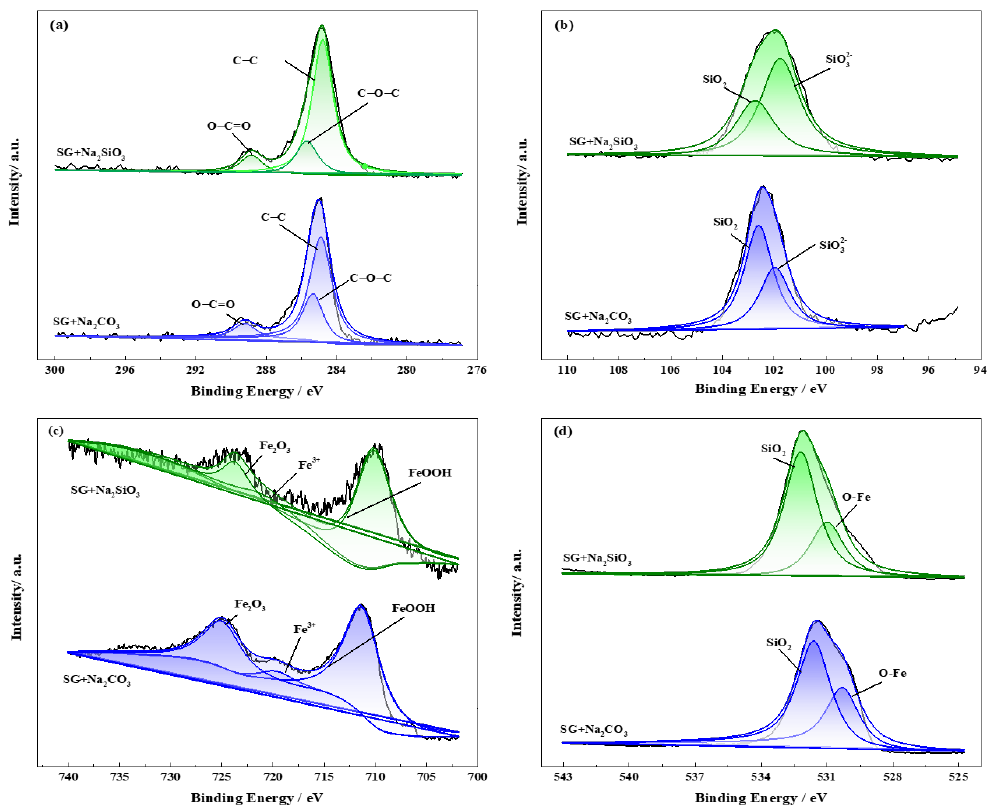
Figure 11. XPS spectra obtained on iron surfaces after 4 weeks immersion in the SG + 20 mM Na 2 CO 3 /Na 2 SiO 3 solution. ( a ) C 1s; ( b ) Si 2p; ( c ) Fe 2p; ( d ) O 1s.